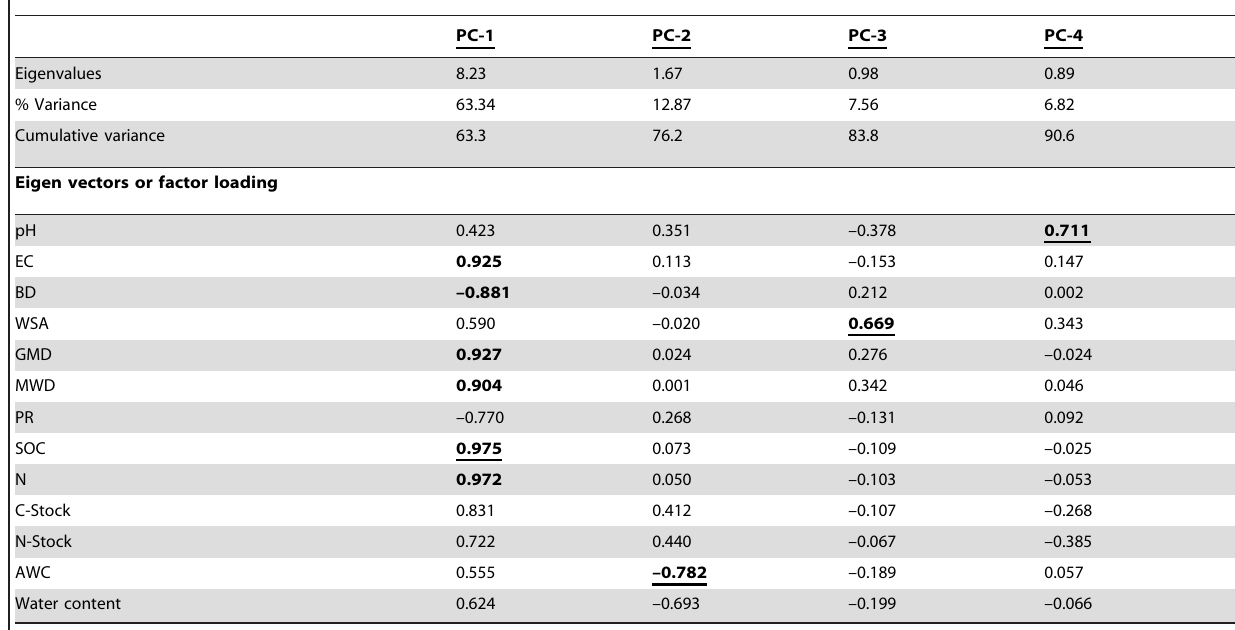
Abbreviations are same as Table 1; PC: principal component; bold values under each component are highly weighted and underlined bold values are selected in minimum data set.